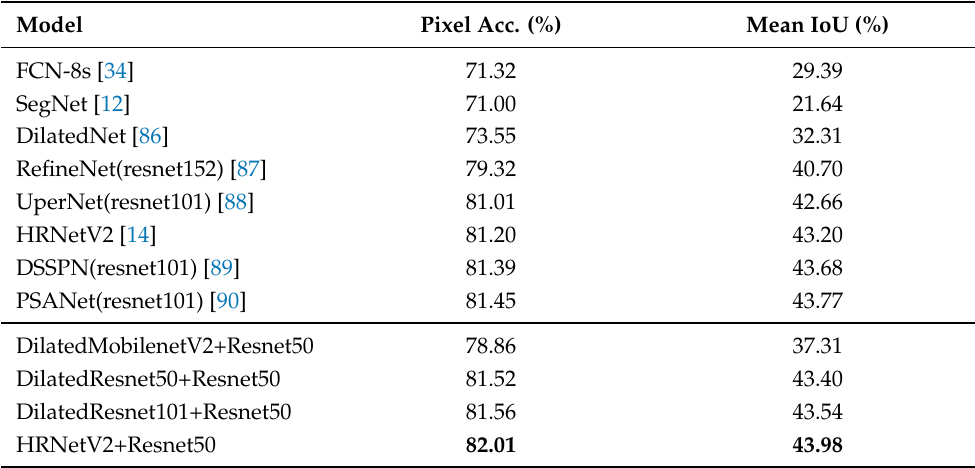
Table 2. Comparison of ADE20k validation set. (For simplicity, we only show the result of models whose depth encoder is Resnet50.)